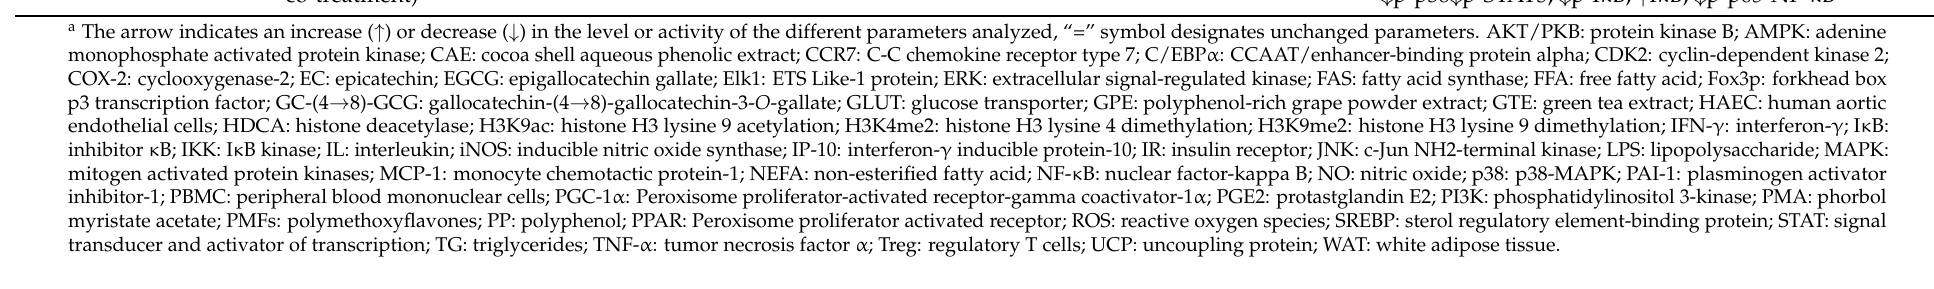
Table 2. Summary of the most relevant effects of flavanol and flavanol-rich product administrations on immunity, inflammation and metabolism during diabetes, obesity and metabolic syndrome in animal and human studies